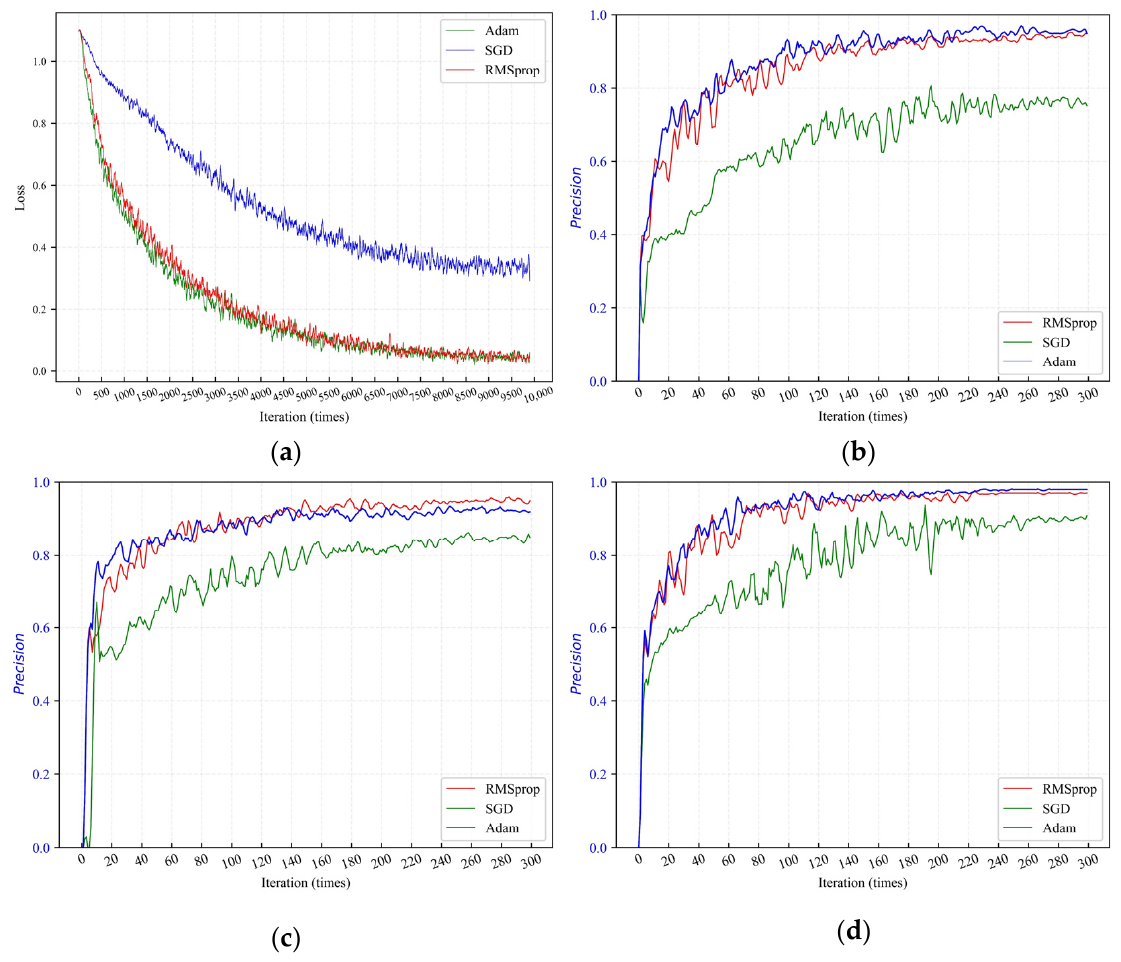
the model using the SGD optimizer performed worse in the classification of all three types